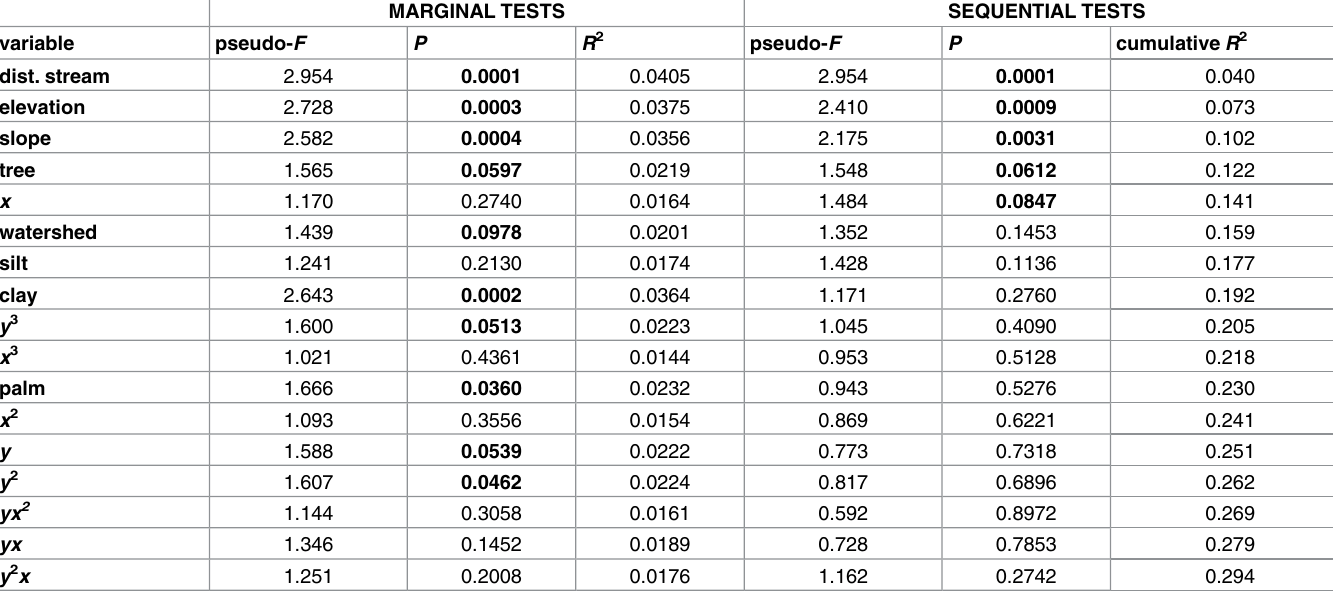
Table 2. Results of DISTLM analyseson all predictors.